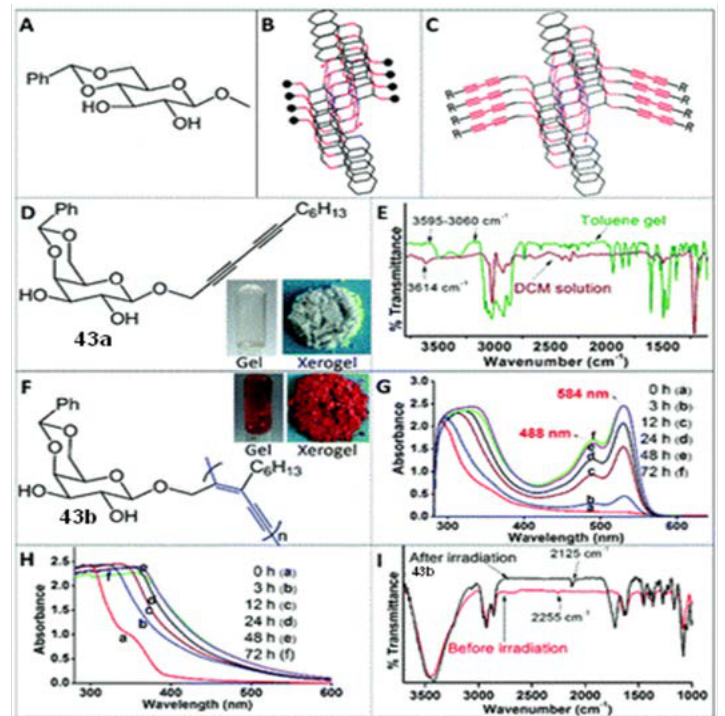
Figure 33. ( A ) Chemical structure and ( B ) packing of 4,6- O -benzylidene methyl β - D -glucopyranoside in its gel showing a stacked arrangement of methyl groups; ( C ) proposed packing arrangement of the diacetylene functionalized gelator; ( D ) chemical structure of a photo-polymerizable organogelator 43a . An inverted test-tube image of the toluene gel is also shown; ( E ) IR spectral comparison of DCM solution with the toluene gel of diyne 43a ; ( F ) chemical structure of 43b obtained by topochemical polymerization of diyne 43a in the gel state. A photograph of the polymerized gel is also shown; ( G ) and ( H ) time-dependent UV-visible spectra of 43a in toluene gel and in DCM solution, respectively; ( I ) an overlay of the FT-IR spectra of the xerogels made before ( 43a ) and after UV-irradiation of toluene gel ( 43b ). Reprinted with permission from [135]. Copyright 2016 Royal Society of Chemistry.